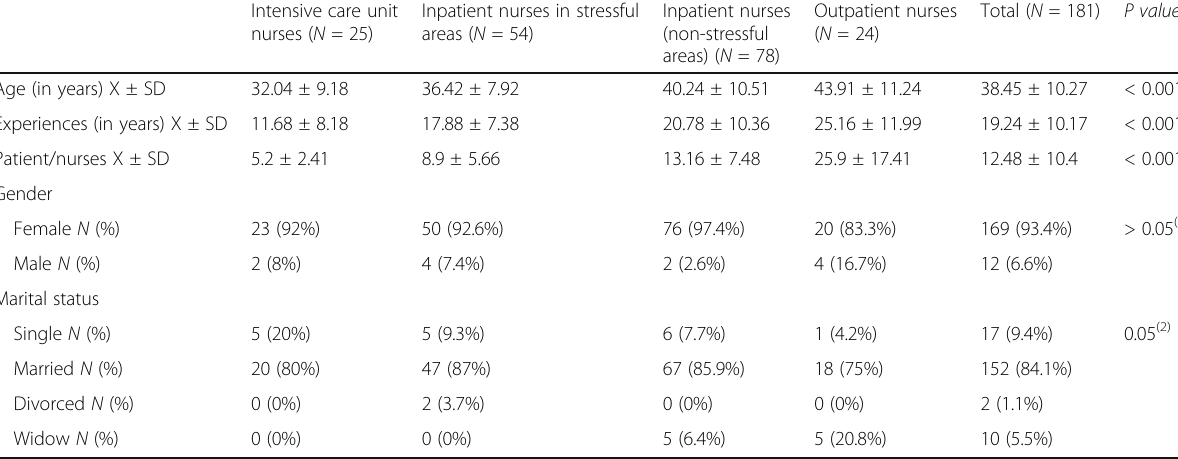
Table 1 Sociodemographic and work characteristics of the studied groups